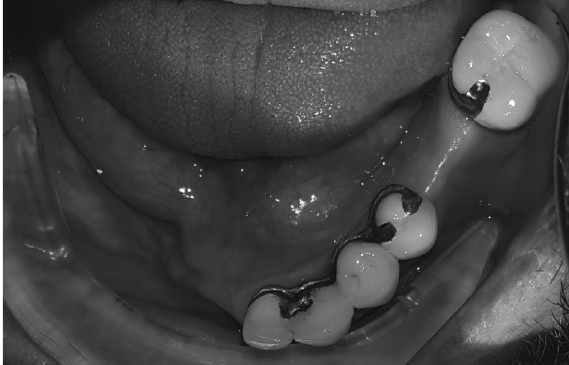
Figure 6: Occlusal surface of fixed prostheses and right mandibular defect due to sequestrectomy.